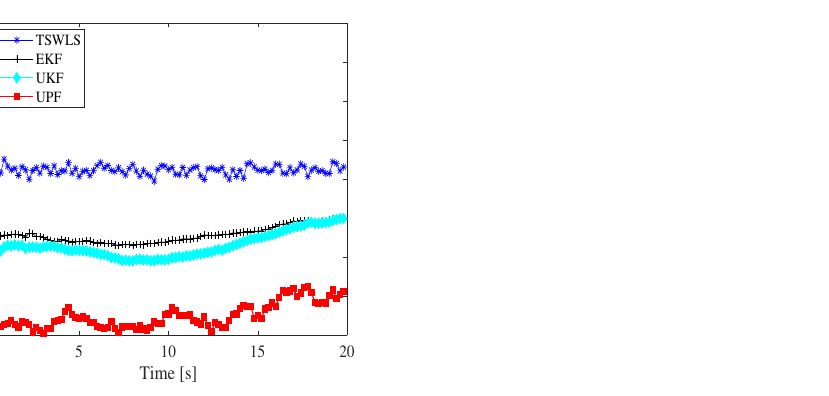
Figure 14. The RMSE of different algorithms in LOS scenario ( σ θ